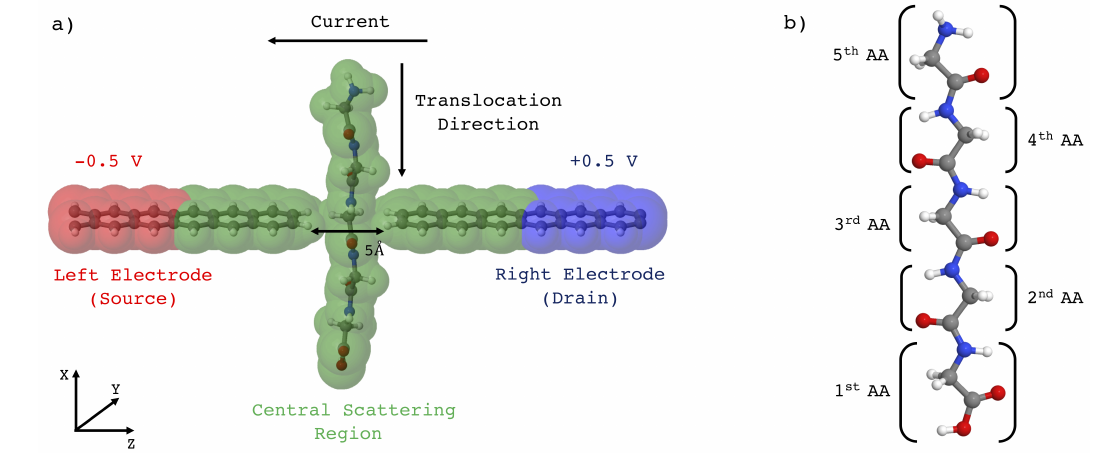
Figure 1. ( a ) atomistic model of peptide sequencing using a 2-ZGNR nanogap device. The